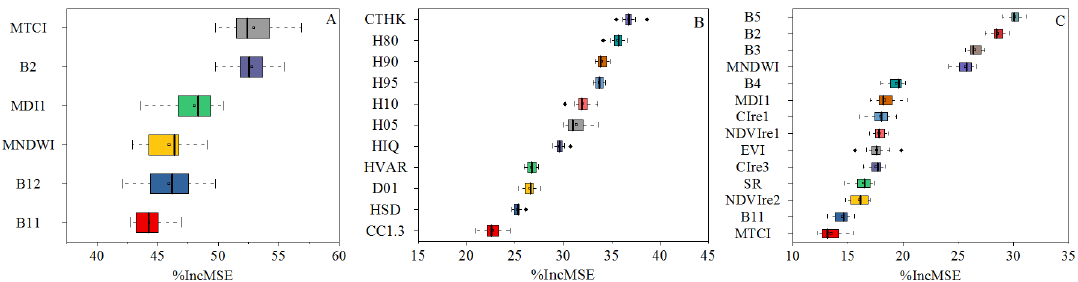
Figure 8. The importance of different variables measured by %IncMSE (the percentage increase in the mean square error) after running the random forest algorithm 100 times: ( A ) the LiDAR~S2 model for height estimation; ( B ) the G~LiDAR model and ( C ) the G~S2 model for AGB estimation.